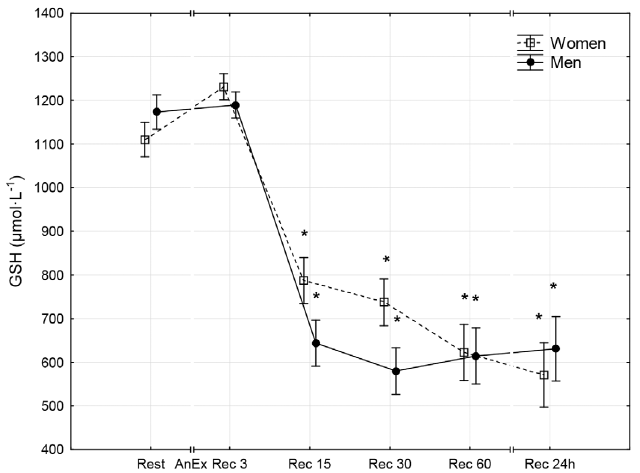
Fig 7. Reduced glutathione concentration (GSH) in the blood prior to (Rest) and 3 minutes (Rec 3), 15 minutes (Rec 15), 30 minutes (Rec 30) and 60 minutes (Rec 60) after anaerobic exercise (AnEx). Data are given as mean ± standard error; * p < 0.05 statistically significant differences between results obtained after anaerobic exercise (AnEx) and initial results (Rest).